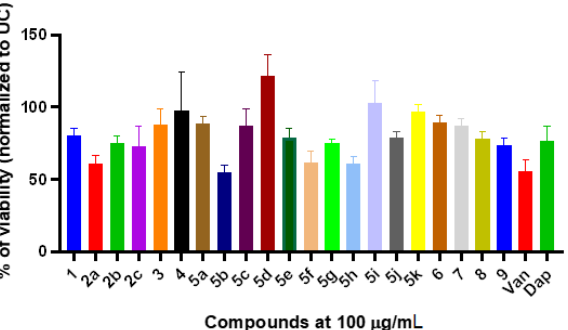
Figure 1. The cytotoxicity evaluation of compounds 1 – 9 in Vero African green monkey kidney cells. The Vero cells were exposed with fixed (100 µg/mL) concentration of each compound or vancomycin (Van) and daptomycin (Dap) that served as a comparator drug. The cells were incubated with test compounds for 48 h and the resulting viability was measured using MTT assay. Data provided in the graphs are mean ± SD from 3 experimental replicas.